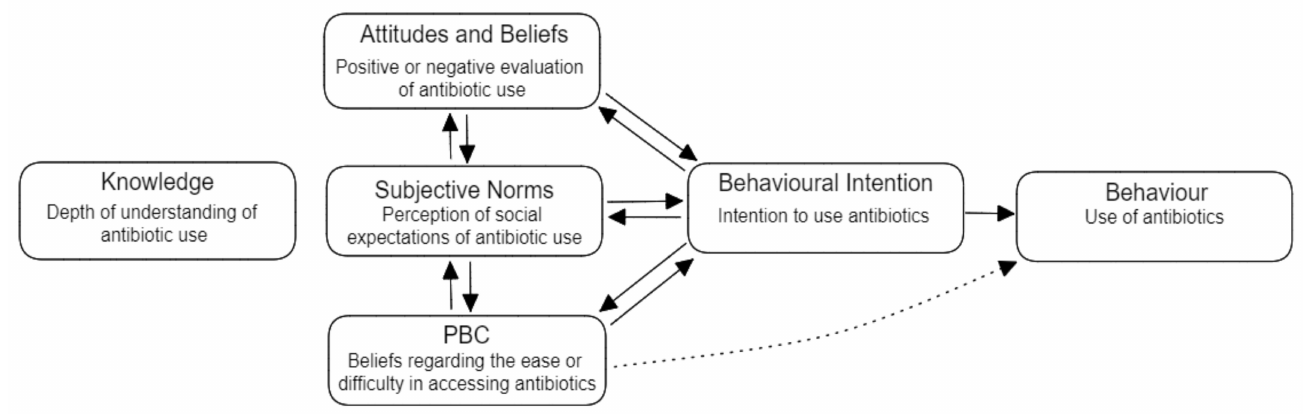
Figure 1. Theory of Planned Behaviour Model, adapted from Ajzen (1991)